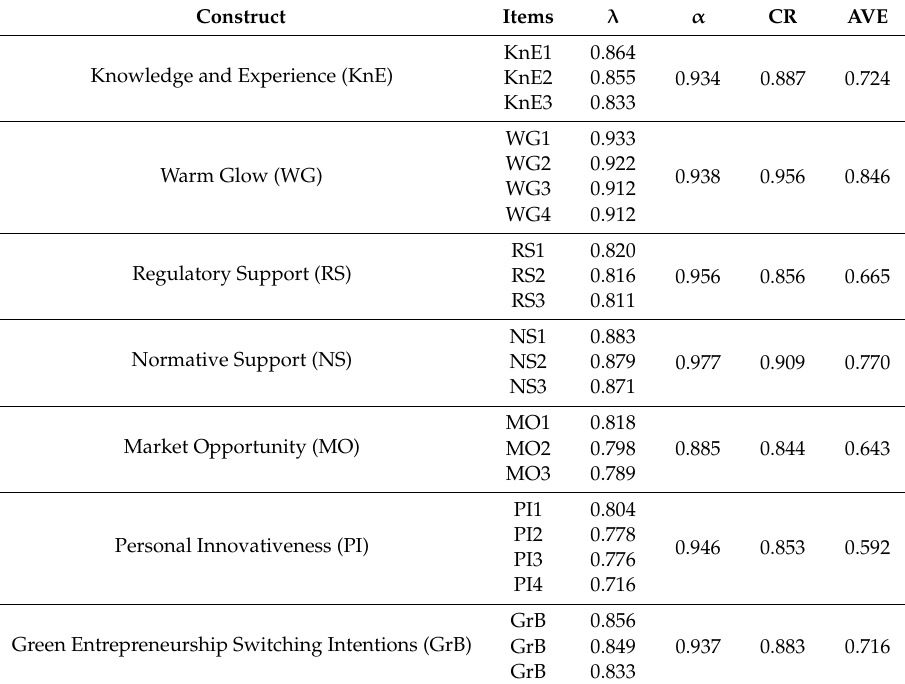
Table 3. Exploring factors and reliability analysis.